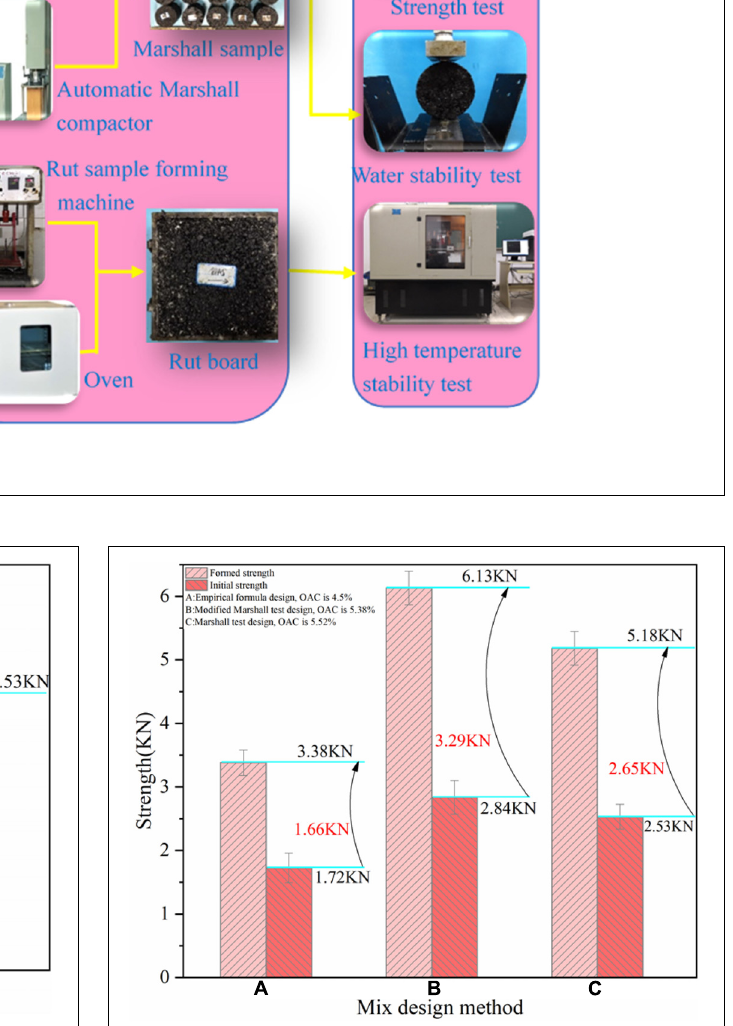
FIGURE 5 | Results for the initial strength of CPAM. FIGURE 6 | Results of forming strength of